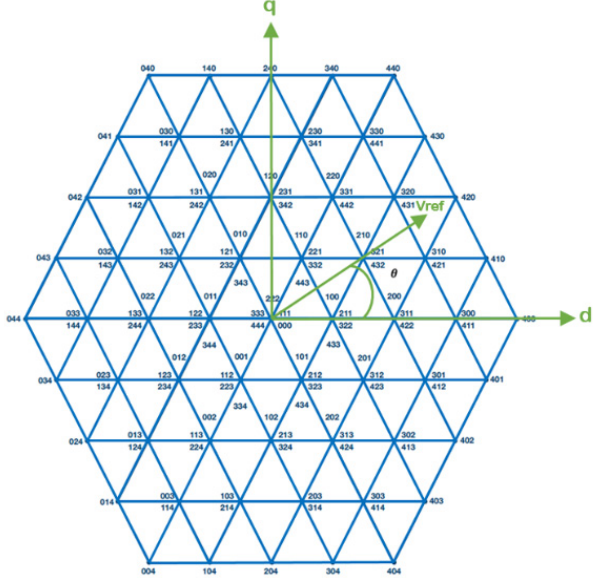
Figure 2. Space vector diagram of five-level inverter.